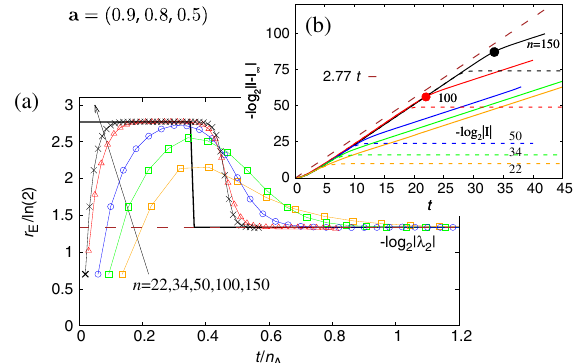
FIG. 15. Entanglement rate for the BW configuration with PBC and a 2-qubit gate with parameters a ¼ ð 0 . 9 ; 0 . 8 ; 0 . 5 Þ . One has a multistage thermalization with rate r nonmaximal (less than for XXZ gates) but still faster than the one calculated from j λ 2 j [dashed brown line at approximately 1.34 in